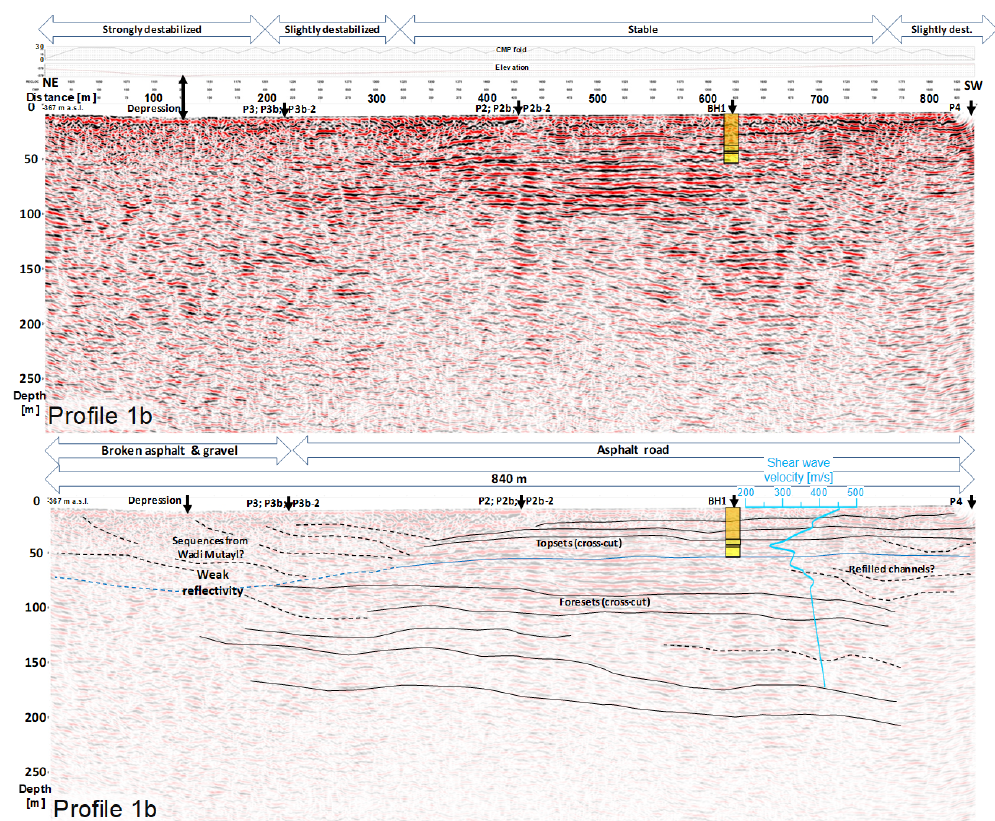
Figure 8. Resulting depth section of profile 1b after post stack FD time migration (a) and interpretation of the main structure elements (b) . Arrow bars at the top of the upper image denote the surface instability/stability as observed along the profile, while arrow bars below denote the road surface situation along the profile and the profile length. Black arrows at the top indicate joints with the crossing profiles. The lithology of borehole BH1 is projected from 10m distance perpendicularly into the profile. The interpreted top of the silt and clay layer in BH1 is shown as the blue line along the profile, since it is the first layer detected at depth that is prone to subrosion. Also shown is the 1-D shear wave velocity–depth function derived from seismic data in this area; this function was used for time-to-depth conversion of all